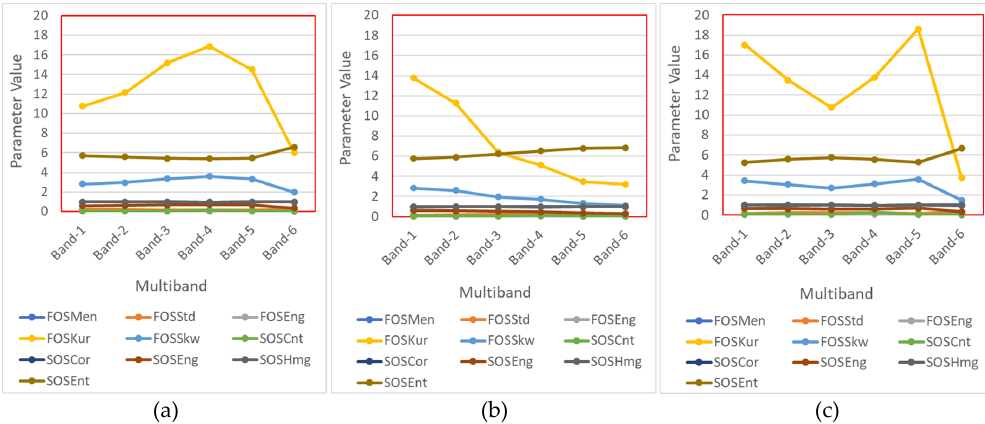
Figure 4. Analyses of multiband first- and second-order textural features of scenes: ( a ) liquid; ( b ) food; and ( c ) leaf.